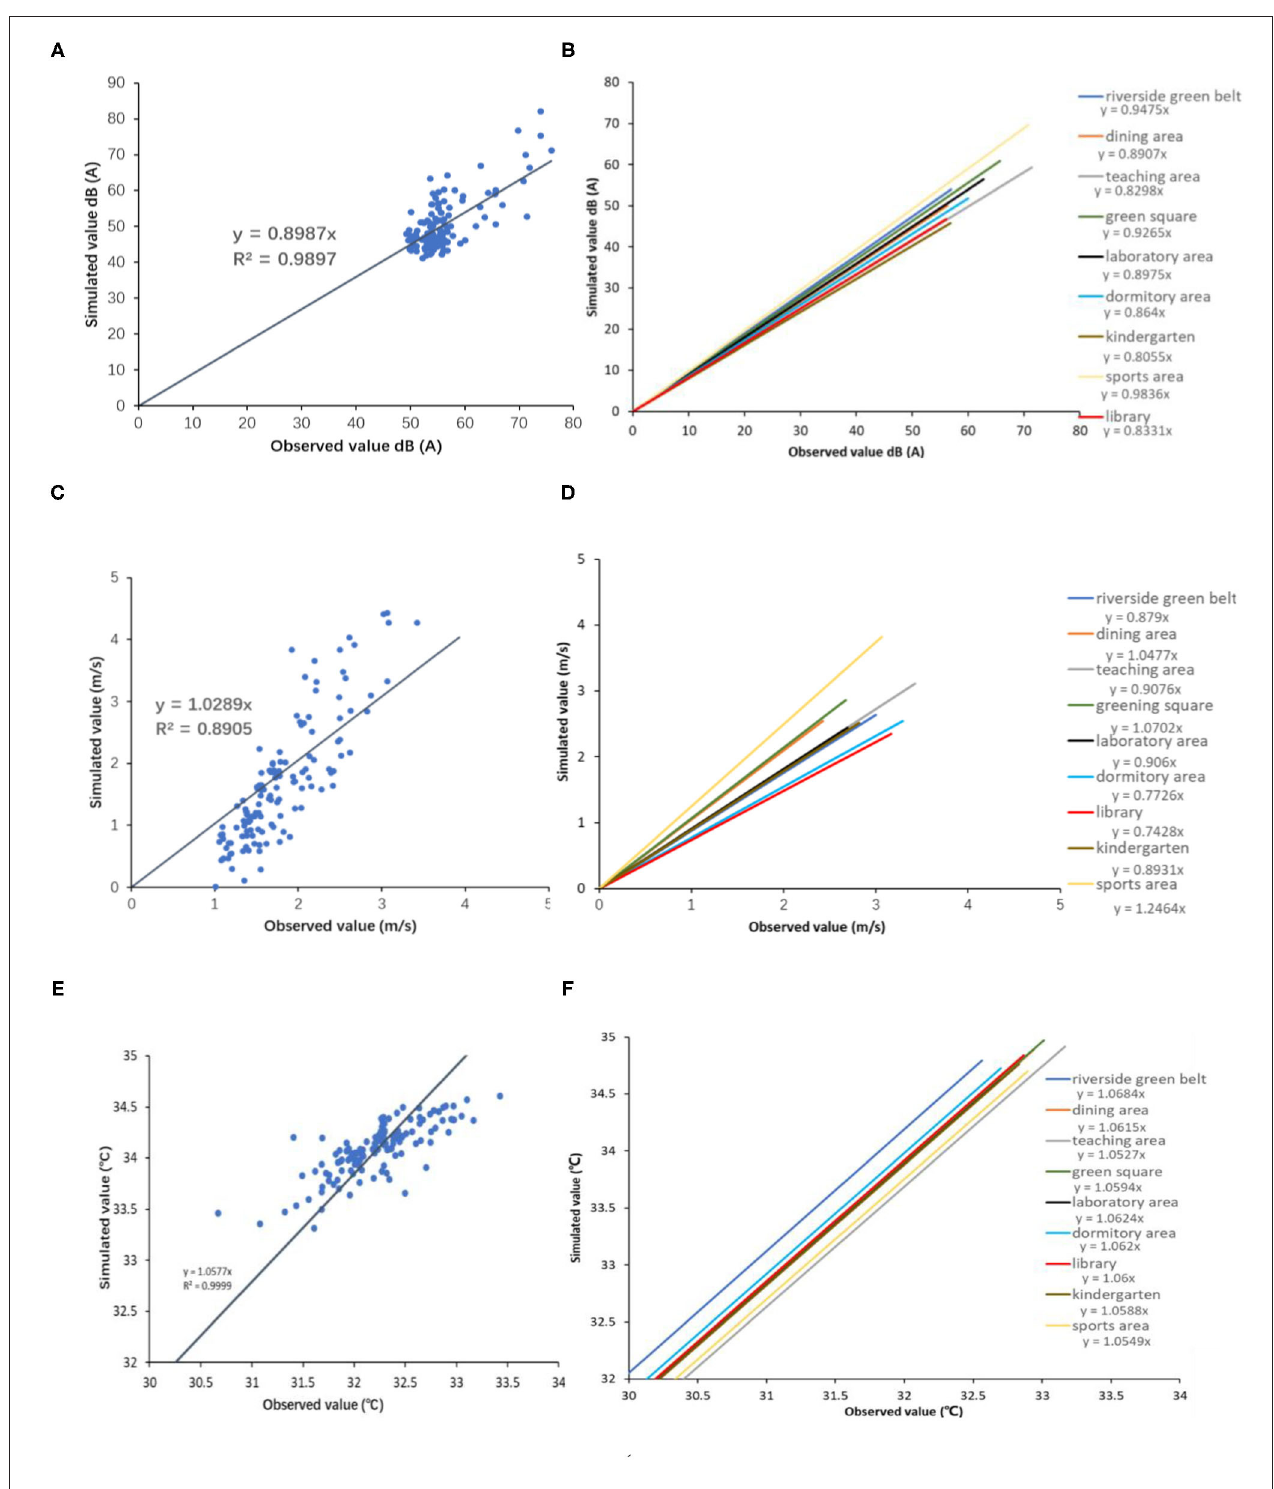
FIGURE 4 | Curves of simulated value and observed value: (A) Performance tests of acoustic environment in whole area, (B) Performance tests of acoustic environment in separated areas, (C) Performance tests of wind environment in whole area, (D) Performance tests of wind environment in separated areas, (E) Performance tests of thermal environment in whole areas, (F) Performance tests of thermal environment in separated areas.